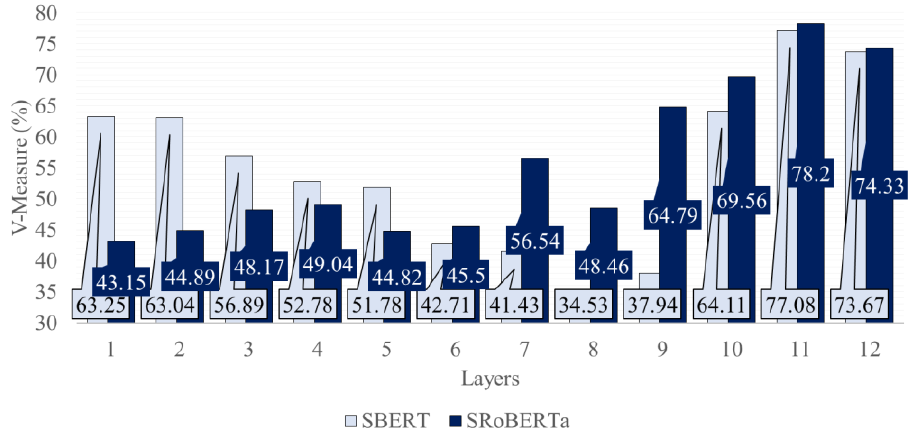
Figure 4. Mean V-measure score amongst the SBERT and SRoBERTa model layers.